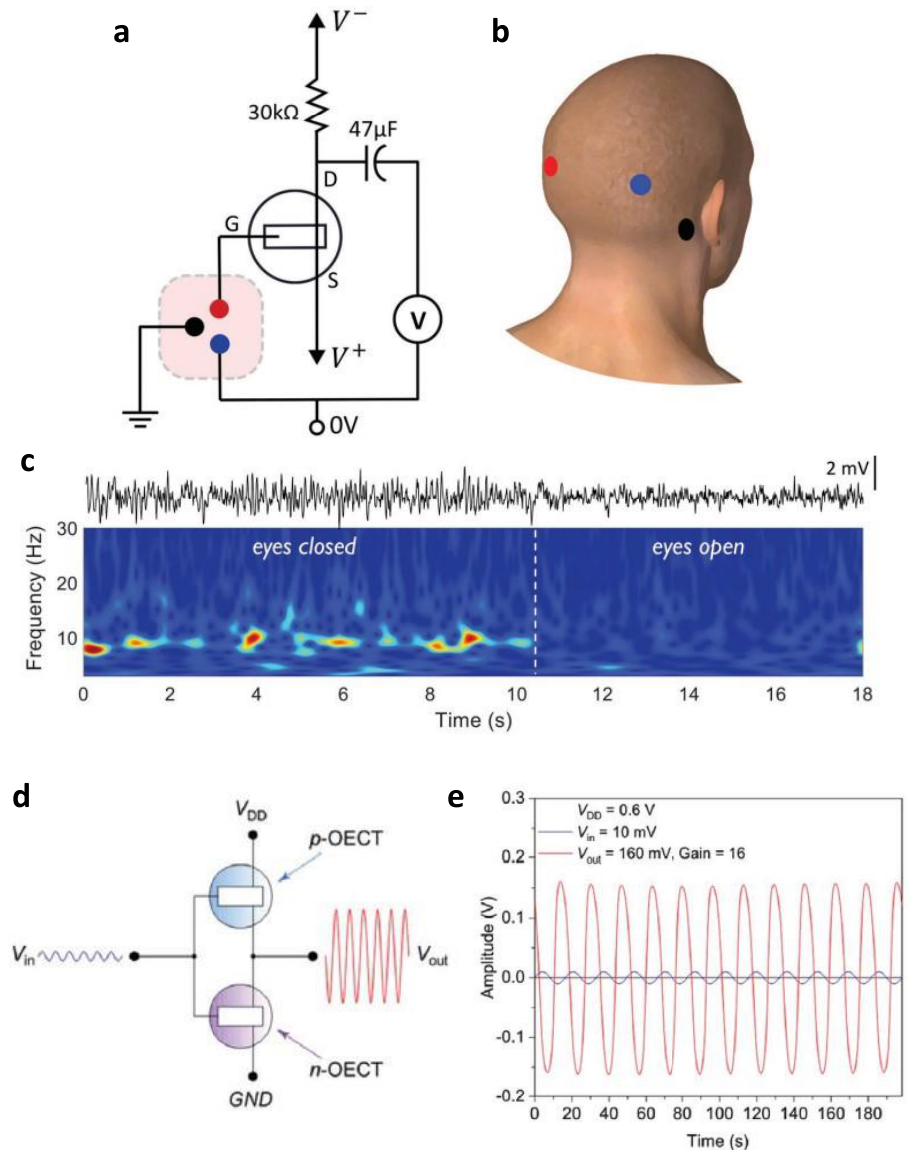
Figure 7. OECT-based thin-film analog circuits. ( a ) A sub-threshold OECT-based voltage amplifier for EEG detection, and ( b ) the detailed location on the scalp of a human to which each electrode is attached. ( c ) Comparison of the observation of the alpha rhythm response, normally activated when the eyes are closed, by converting the EEG signals when the eyes are closed and when they are open into time-frequency plots (adapted from [ 78 ] with permission from John Wiley and Sons). ( d ) Circuit diagram of OECT-based complementary amplifier and ( e ) corresponding input/output characteristic (adapted from [ 79 ] with permission from John Wiley and Sons).